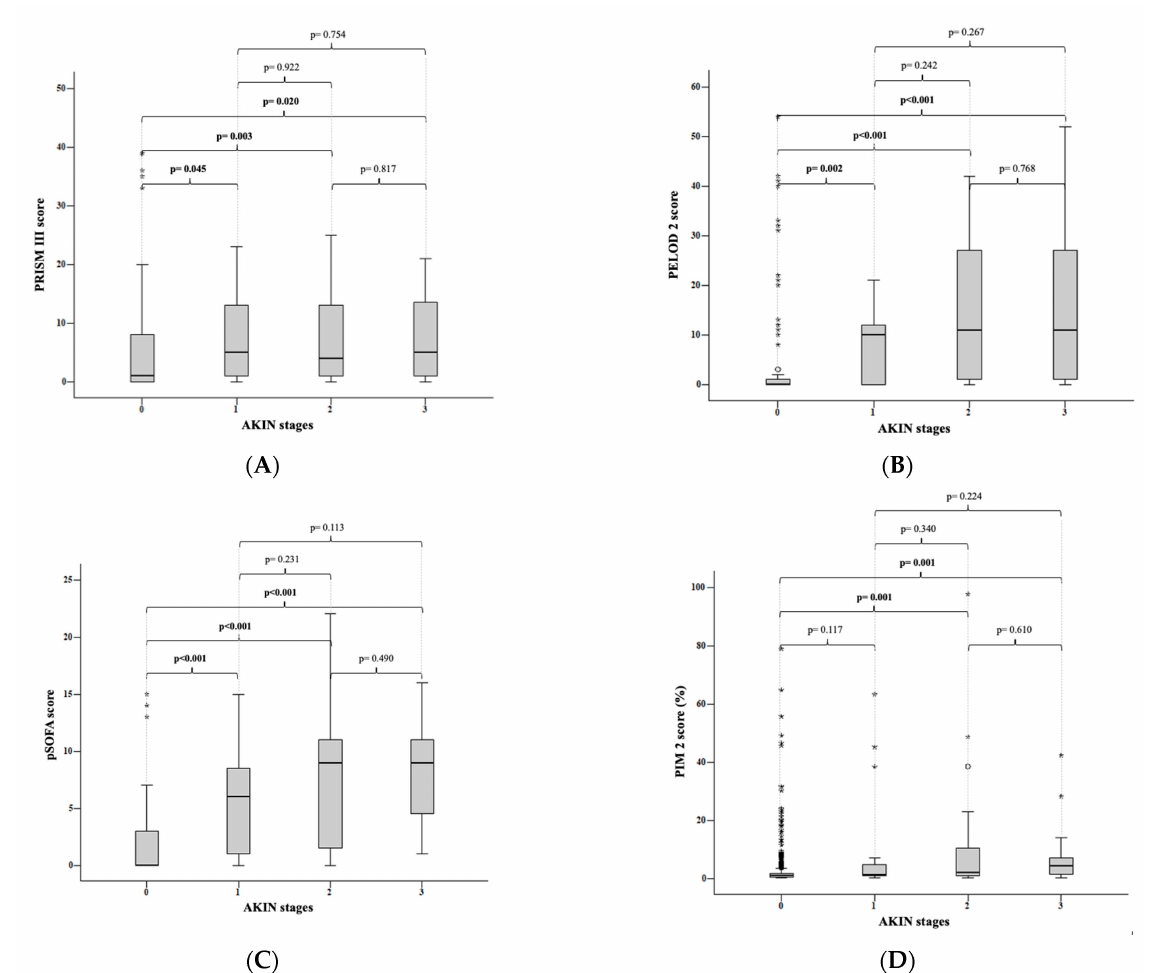
Figure 1. ( A ) AKIN stages and PRISM III scores: The stages of kidney injury according to the AKIN criteria were compared with the PRISM III scores. A significant difference was found between the patients who did not develop kidney injury and those who developed stage 1 ( p = 0.045), stage 2 ( p = 0.003), and stage 3 ( p = 0.020) kidney injury. There was no significant difference between stages 1 and 2 ( p = 0.922), between stages 1 and 3 ( p = 0.754), and between stages 2 and 3 ( p = 0.817). ( B ) AKIN stages and PELOD 2 scores: When the medians of the PELOD 2 score were compared with the stages of kidney injury according to the AKIN criteria, there was a significant difference between patients who did not develop kidney injury and those who developed stage 1 ( p = 0.002), stage 2 ( p < 0.001), and stage 3 ( p < 0.001) kidney injury. There was no significant difference between stage 1 and 2 kidney injuries ( p = 0.242), between stage 1 and 3 kidney injuries ( p = 0.267), and between stage 2 and 3 kidney injuries ( p = 0.768). ( C ) AKIN stages and pSOFA scores: According to the AKIN criteria, there was a statistically significant difference between patients who did not develop kidney injury and those who developed stage 1 ( p < 0.001), stage 2 ( p < 0.001), and stage 3 ( p < 0.001) kidney injury. While there was a statistically significant difference between stages 1 and 2 ( p = 0.231), there was no statistically significant difference between stages 1 and 3 ( p = 0.113) and between stages 2 and 3 ( p = 0.490). ( D ) AKIN stages and PIM 2 scores: According to the AKIN criteria, there was no significant difference between the patients who did not develop renal injury and those who developed stage 1 ( p = 0.117) kidney injury when the stages of kidney injury were compared with the medians of the PIM-2 score. There was a significant difference between patients without kidney injury and patients with stage 2 ( p = 0.001) and stage 3 ( p = 0.001) kidney injury. There was no significant difference between stage 1 and 2 kidney injuries ( p = 0.340), between stage 1 and 3 kidney injuries ( p = 0.224), and between stage 2 and 3 kidney injuries ( p =